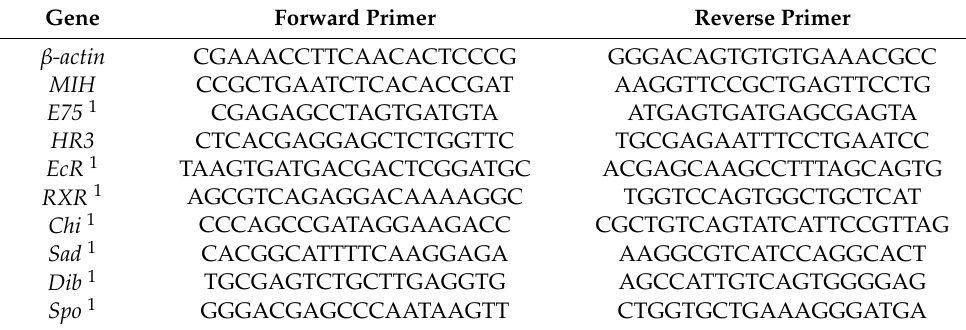
Table 1. Primer sequence used in the